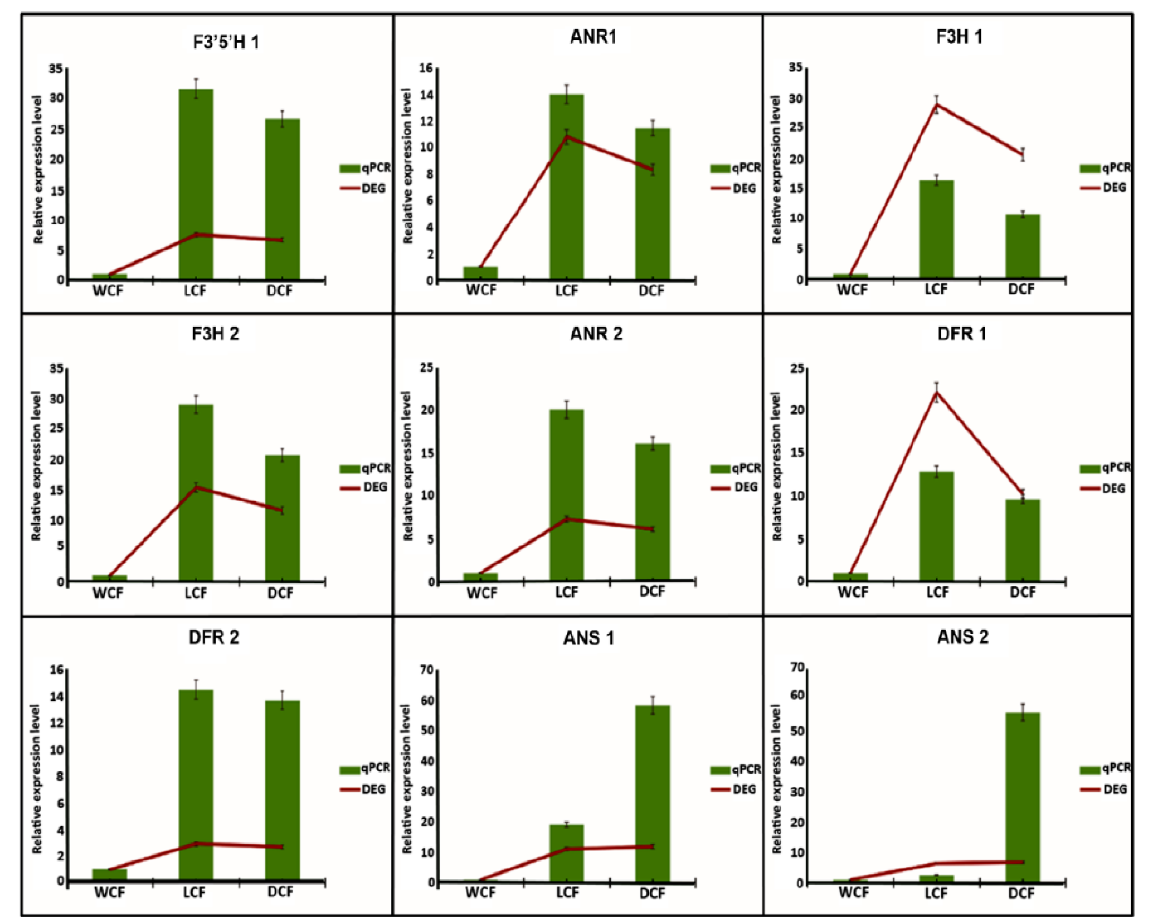
Figure 8. Validation of RNA-seq data by qRT-PCR. Columns represent the results of qRT-PCR, and zigzag lines indicate the results of differentially expressed gene levels.